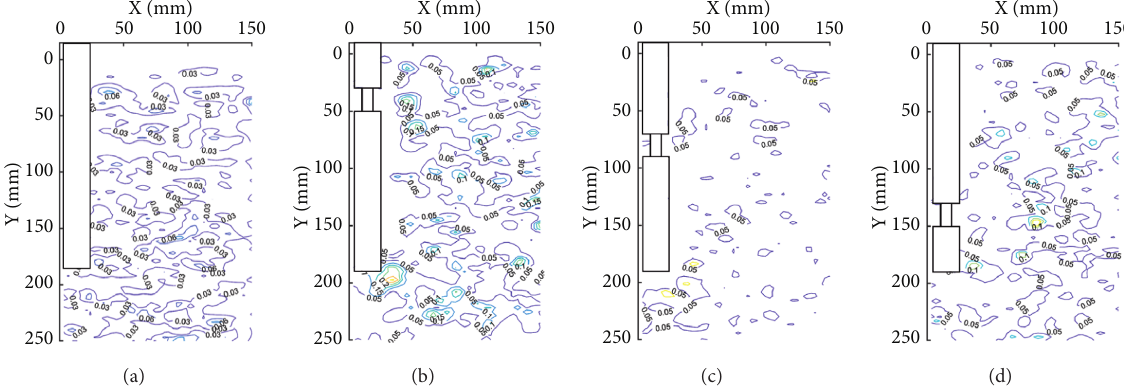
Figure 8: Displacement contour map of soil around the single pile under 140N load level. (a) Intact pile. (b) Necking in the shallow